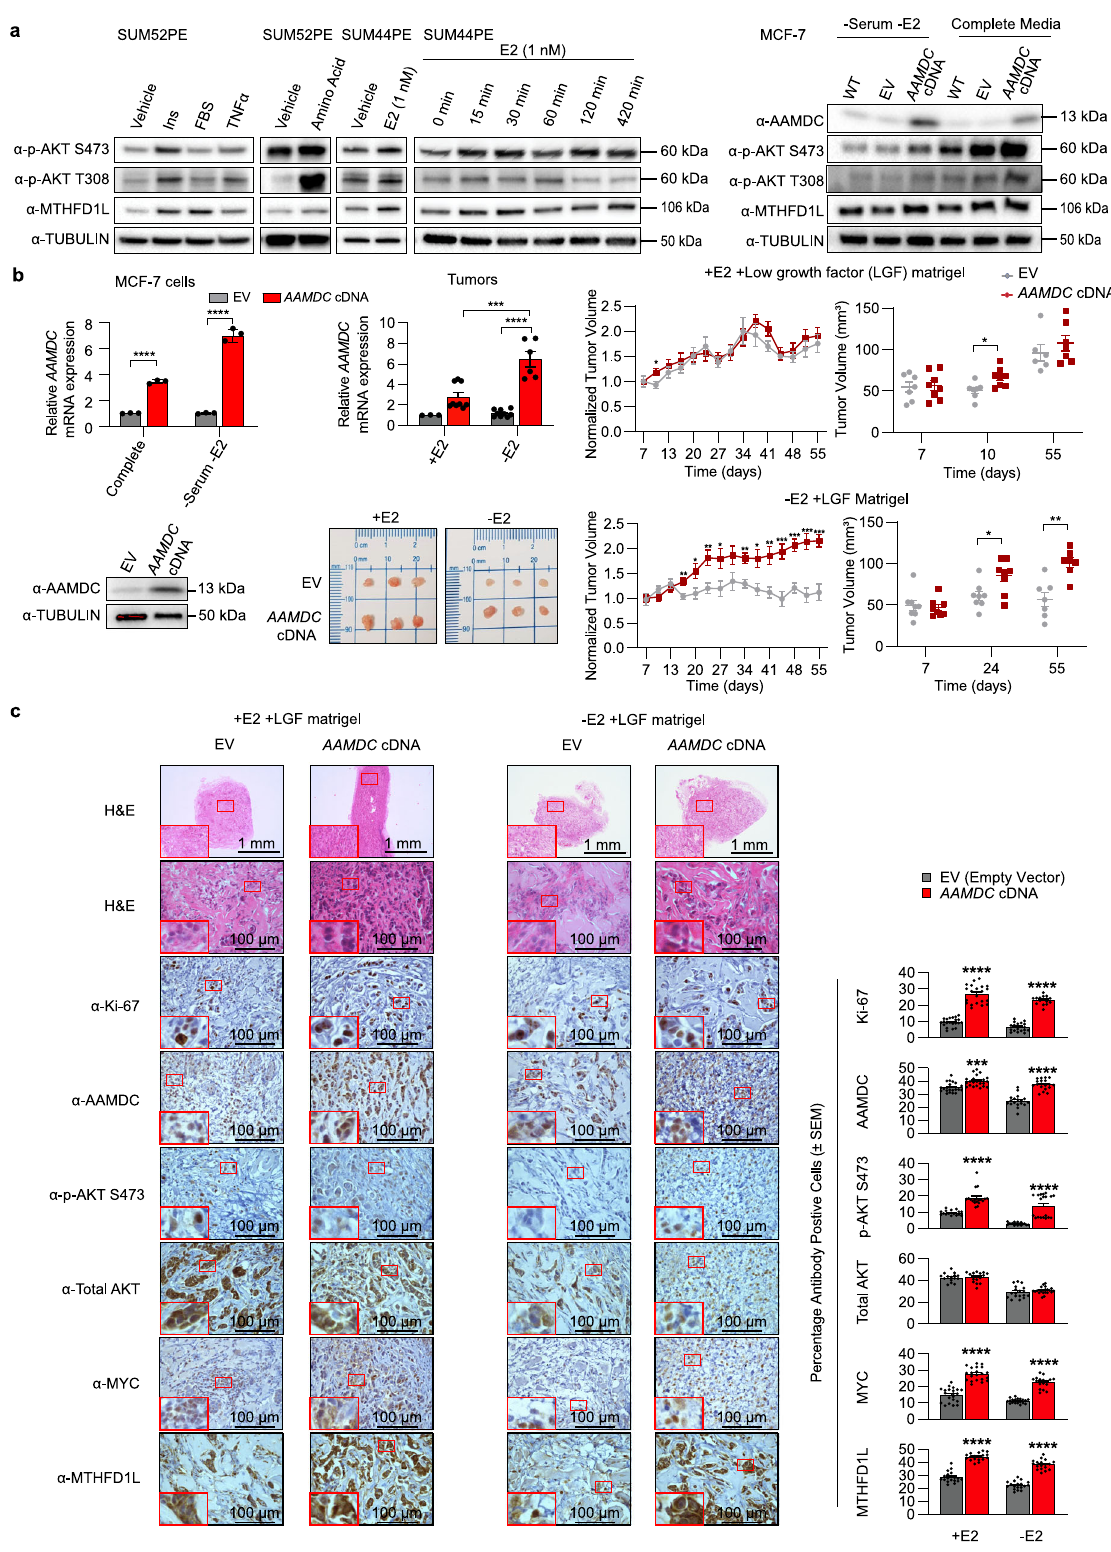
Molecular modeling . Molecular modeling of the bacterial and human AAMDC incubator in a humidi fi ed atmosphere. The MDA-MB-231 and HEK293T cells protein structures was performed with Phyre2 (v2.0). Protein Data Bank (PDB) were grown in DMEM high glucose-pyruvate medium containing 10% FBS and 1% structures shown in Fig. 8 are available under the accession codes IHN https://doi. antibiotic-antimycotic. The HEK293FT cells were cultured in DMEM containing org/10.2210/pdb1IHN/pdb 54 and 2AB1, https://doi.org/10.2210/pdb2AB1/pdb 55 . 0.3 mg/mL glutamine, 100 IU/mL penicillin, and 100 μ g/mL streptomycin supple- mented with 10% fetal calf serum (FCS) and 400 μ g/mL Geneticin (Thermo Fisher Scienti fi c). The MDA-MB-134 cells were cultured in DMEM high glucose-pyruvate Cell culture . All of the cell lines used in the study were authenticated, Mycoplasma - medium supplemented with 20% FBS and 1% penicillin-streptomycin. The MCF-7 free and commercially available. All of the cells were cultured at 37 °C in a 5% CO 2 NATURE COMMUNICATIONS| (2021) 12:1920 |https://doi.org/10.1038/s41467-021-22101-7|www.nature.com/naturecommunications